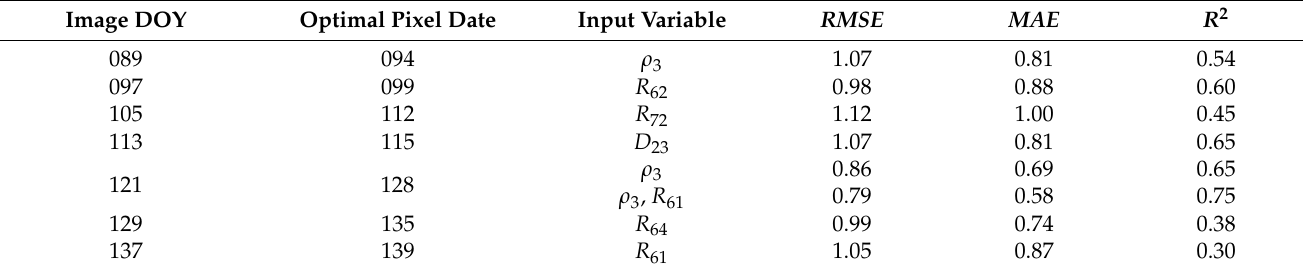
Table 4. Results of SOM prediction models for Phaeozems based on seven images.